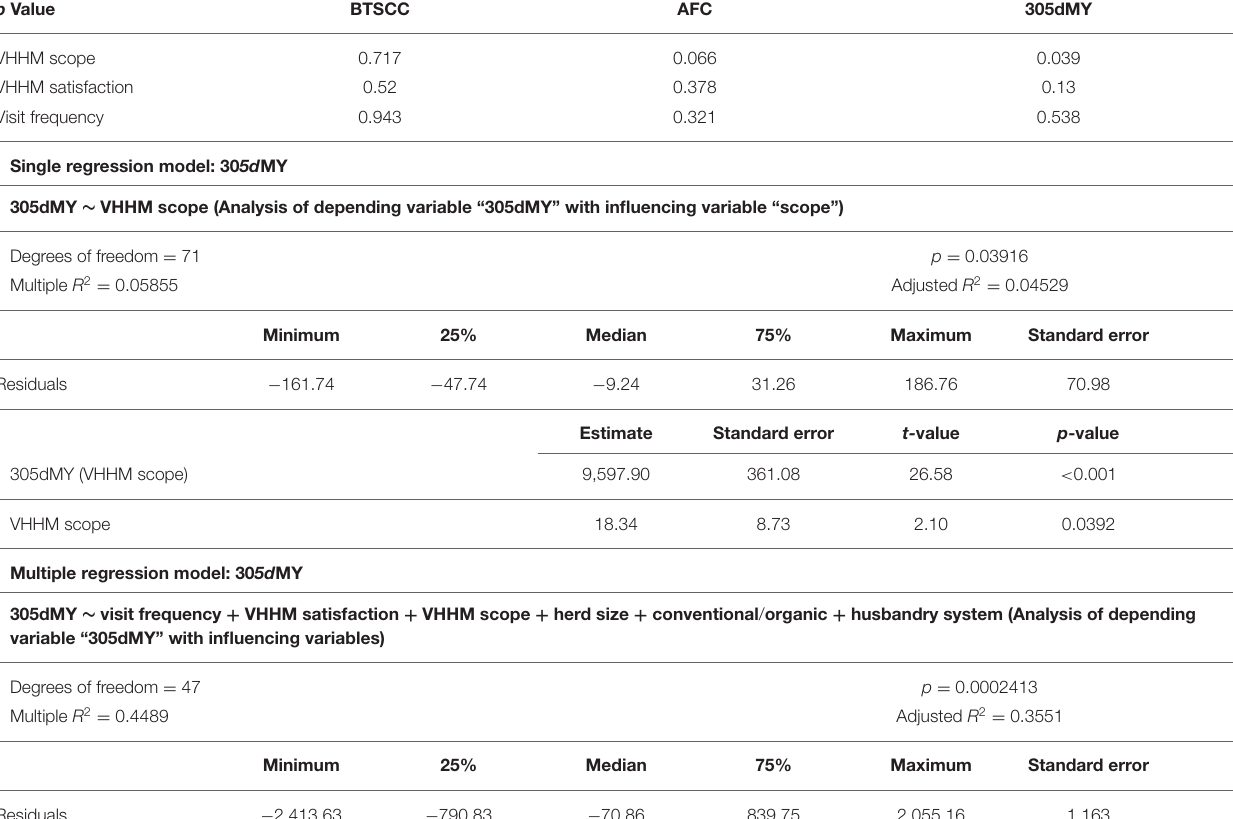
TABLE 6 | VHHM participants: single/multiple regression models survey among German dairy farmers on VHHM participation ( n = 216). Single regression